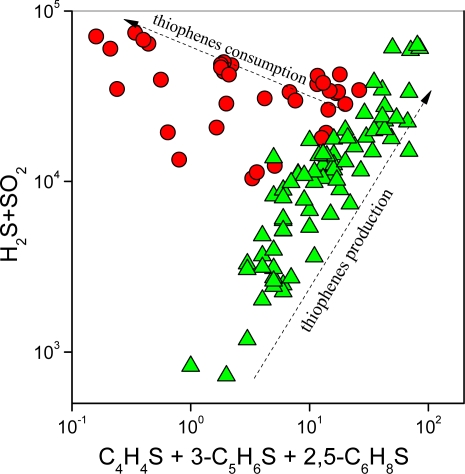
(H2S + SO2) vs. (C4H4S + 3C5H6S + 2,4C6H8S) binary diagram. Green triangle: H gas; red circle: M gas.